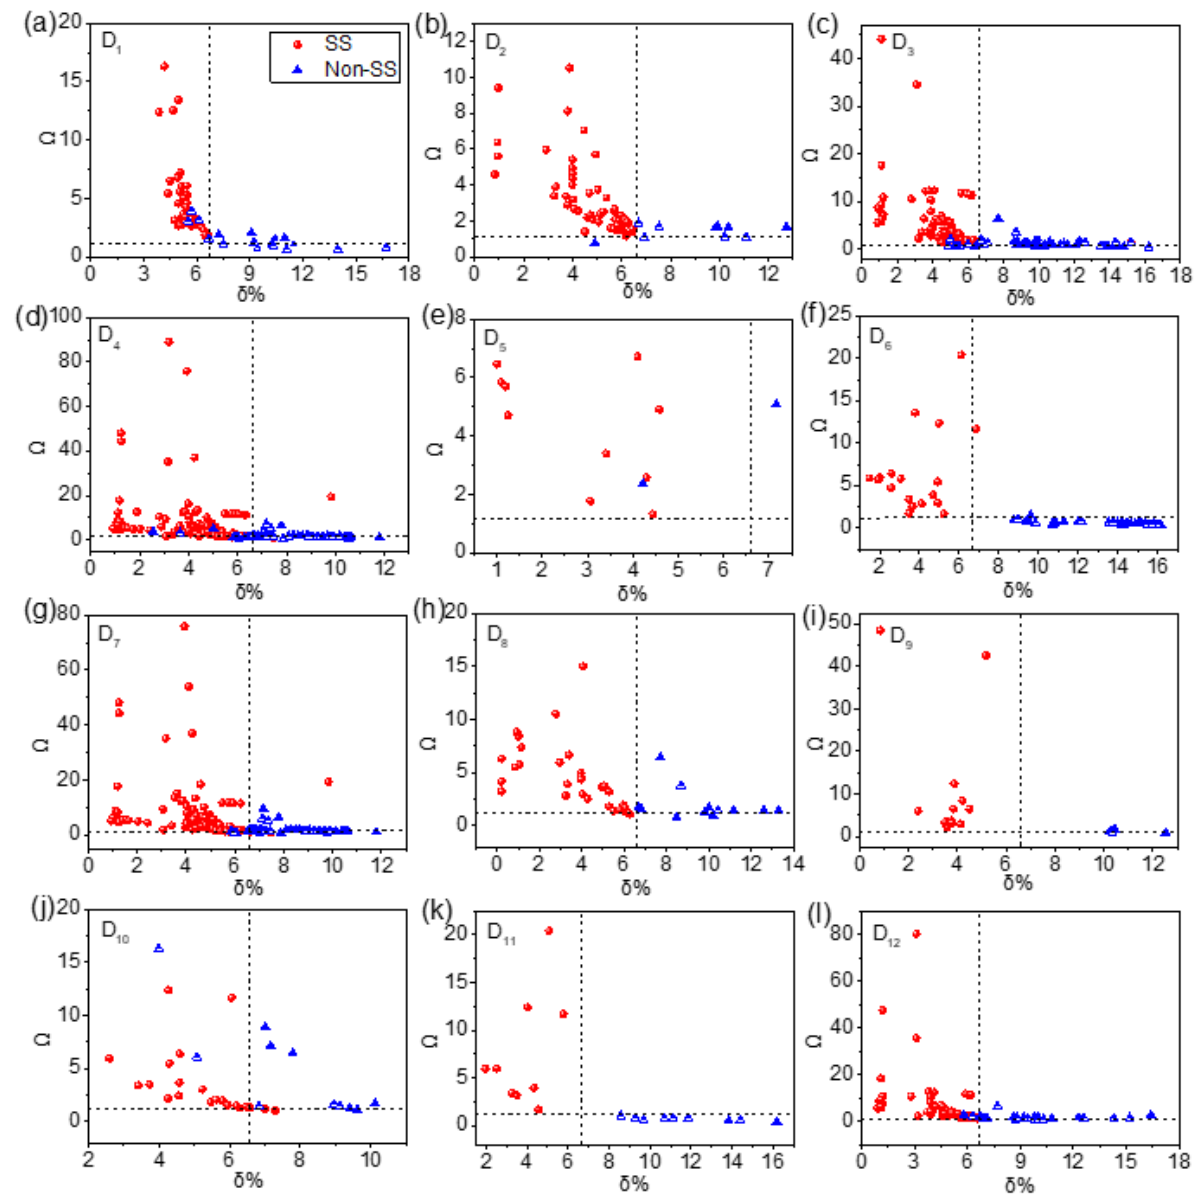
d -W Figure 10. Scatter plot based on the coordinate system. ( a ) D1, ( b ) D2, ( c ) D3, ( d ) D4, ( e ) D5, Figure 10. Scatter plot based on the δ − Ω coordinate system. ( a ) D1, ( b ) D2, ( c ) D3, ( d ) D4, ( e ) D5, ( f ) D6, ( g ) D7, ( h ) D8, ( i ) D9, ( g ) D10, ( k ) D11, ( l ) D12. ( f ) D6, ( g ) D7, ( h ) D8, ( i ) D9, ( j ) D10, ( k ) D11, ( l )